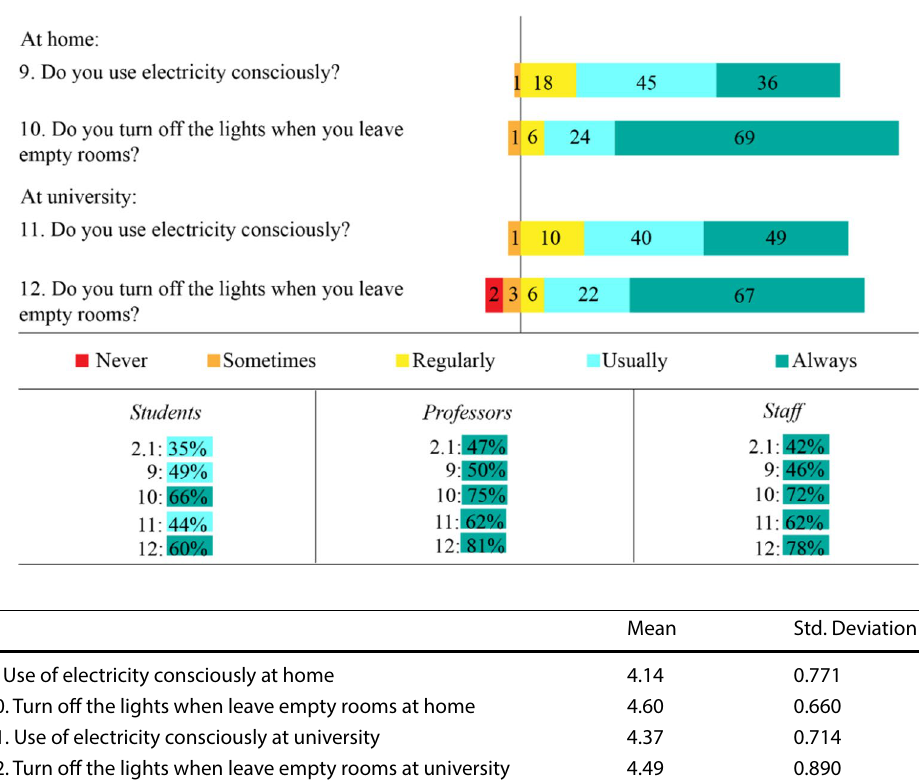
Fig. 3 Frequency indicated by respondents to the behaviour section, regarding conscious use of electricity and the practice of turning off lights, at home at and the university